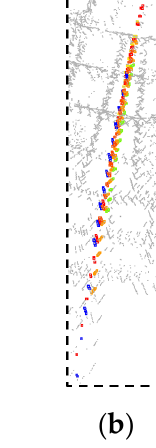
Figure 20. Established conjugate stringers for the West Lafayette dataset: ( a ) conjugate stringers from 13 scans (colored by stringer ID) and ( b ) a zoomed-in region for one stringer (colored by scan ID) (edge points are colored with grey).